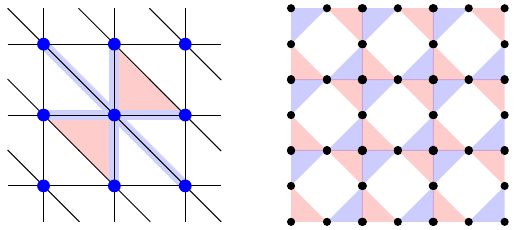
FIG. 2. Left: merging top left and bottom right vertices of all faces of a hexagonal tessellation leads to a tiling of bow ties. The X and Z stabilizers belonging to the merged vertex in the center are highlighted in blue and red. Both are weight-6 operators. Right: we can redraw the lattice by exchanging edges with vertices representing the broken stabilizers as